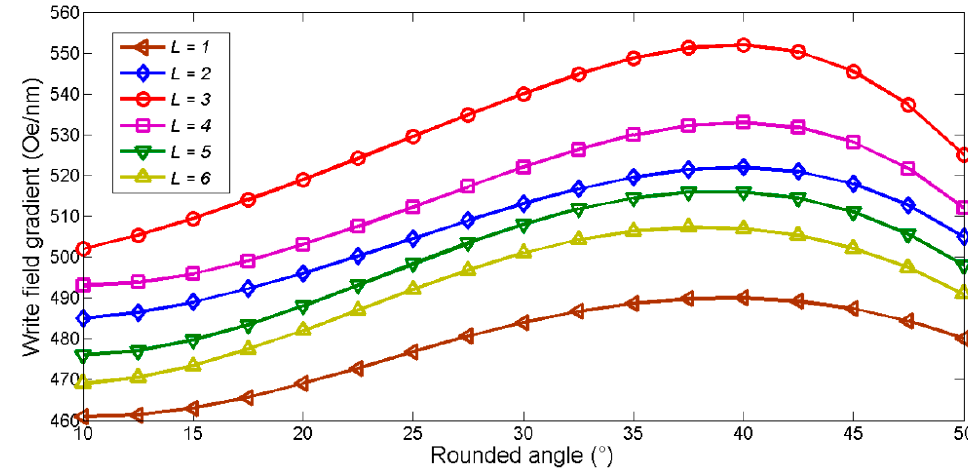
Figure 5. Write field gradient with different rounded angle ( θ ) and corner length ( L ).